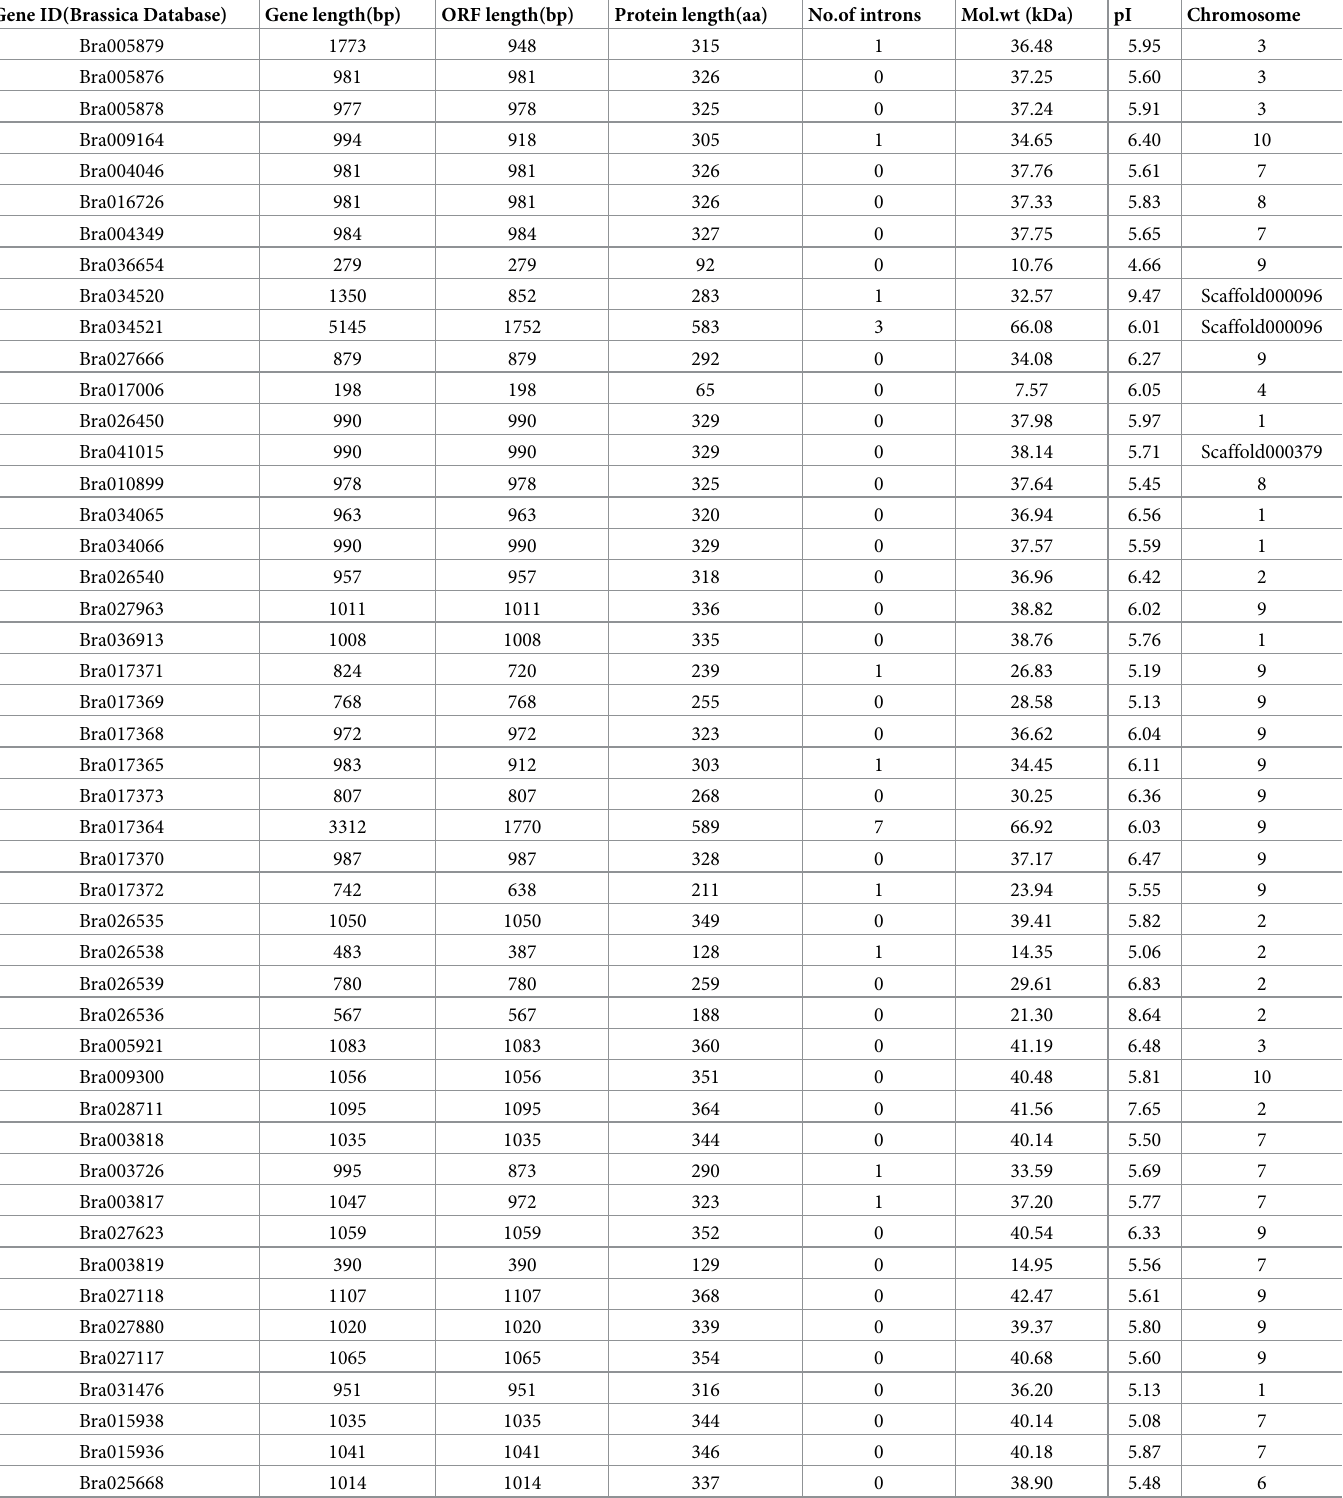
Table 1. Features of the SOT domain protein family in Brassica rapa . Gene ID(Brassica